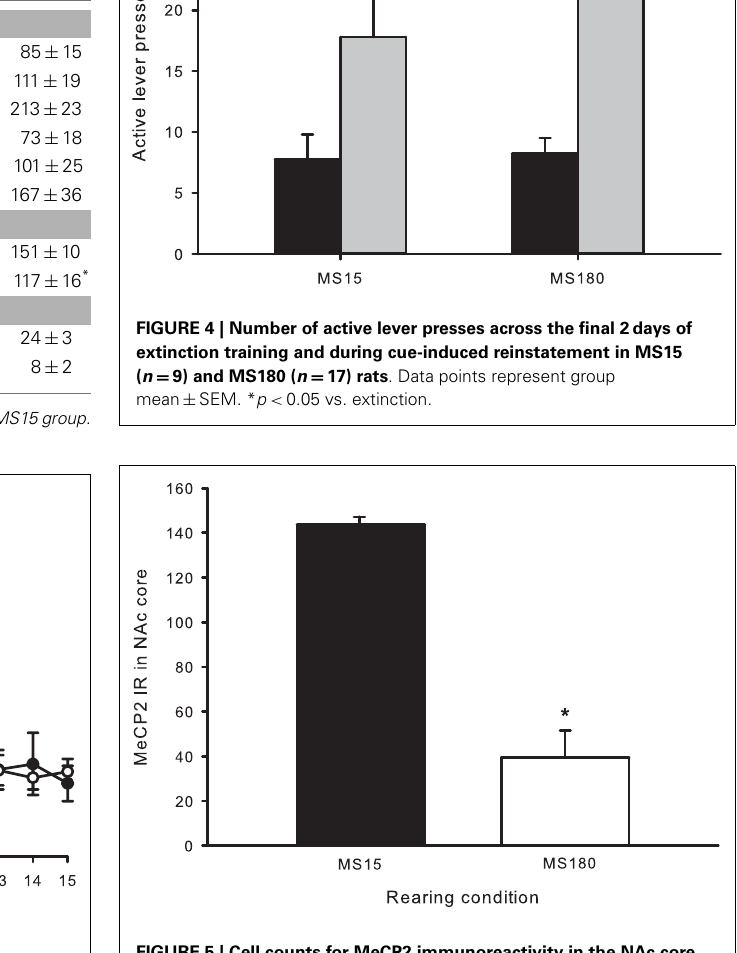
FIGURE 3 |Average number of active lever presses per 2-h session for 15 consecutive days during extinction in MS15 ( n = 9) and MS180 ( n = 17) rats . Data points represent group mean ± SEM. No significant differences between rearing conditions were observed.